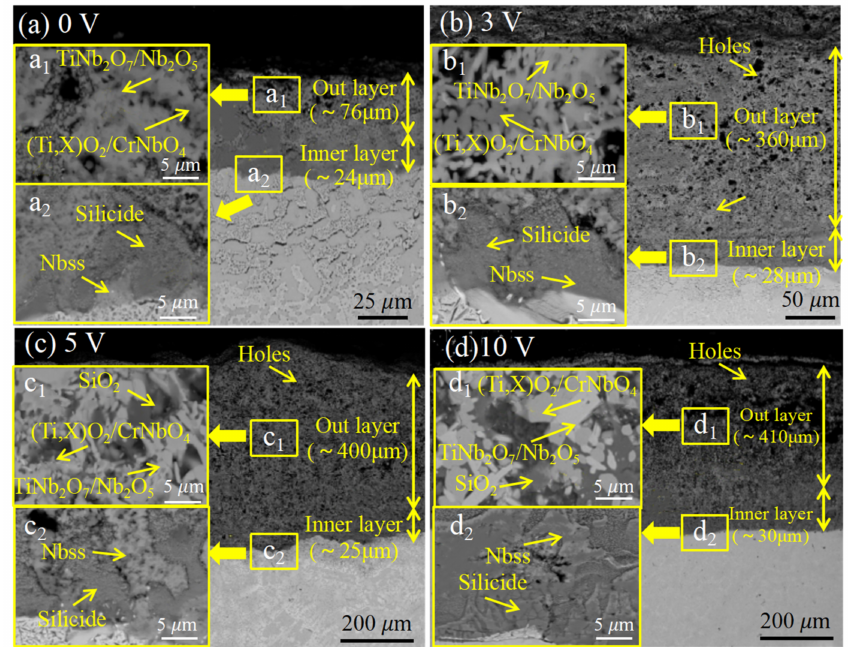
Figure 14. Cross-sectional and enlarged (a 1 –d 1 , a 2 –d 2 ) BSE images of scales of the Nb-Si-based alloys with different V content oxidized at 1250 ◦ C for 1 h: ( a ) (a1, a2) 0 at.%V. ( b ) (b1, b2) 3 at.% V. ( c ) (c1, c2) 5 at.%V. ( d ) (d1,d2) 10 at.%V. Copyright 2020